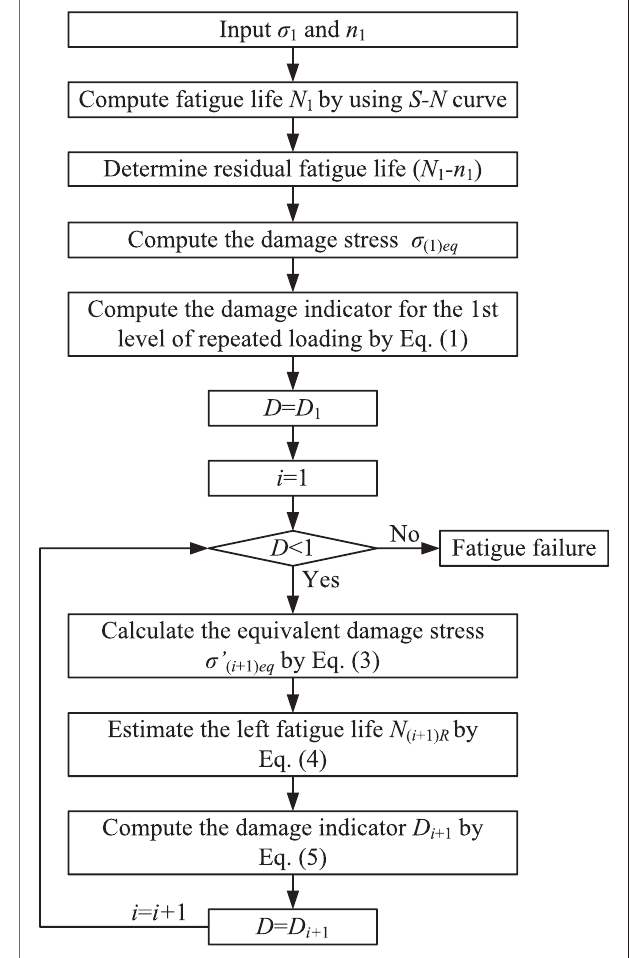
FIGURE 2 | Flowchart for damage calculation using the sequential law.